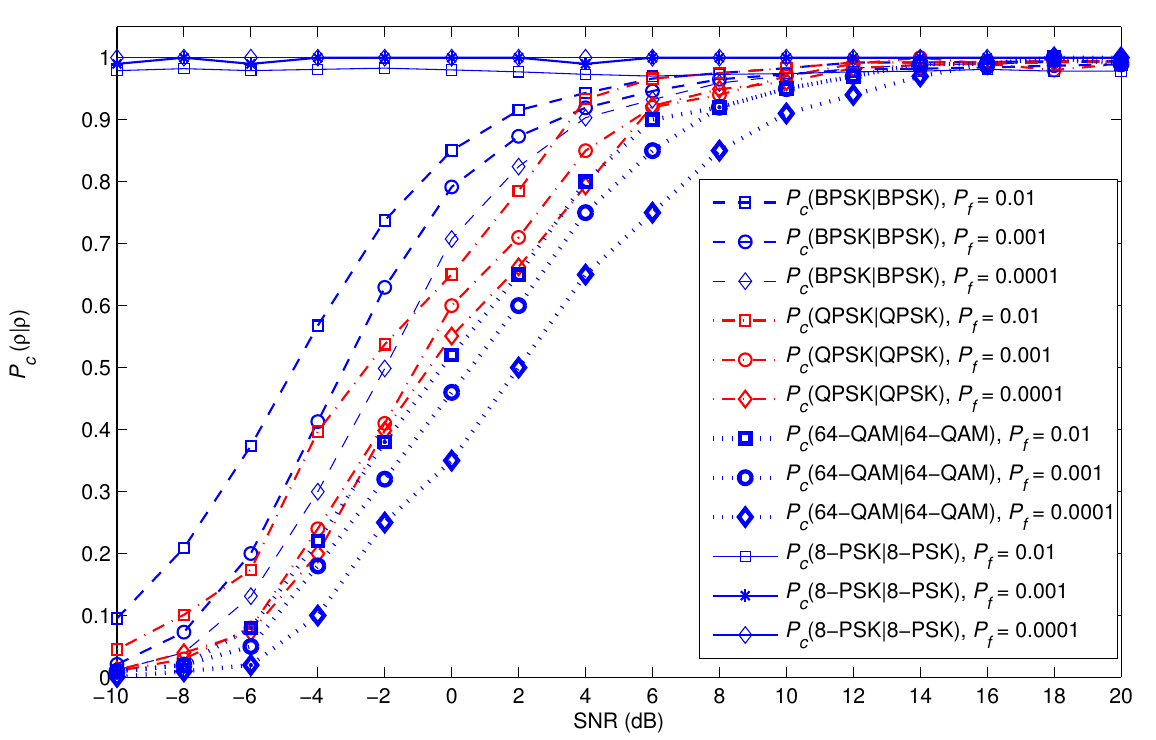
Figure 14. The effect of P f on the categorization performance for the modulation set of Ω 3 .